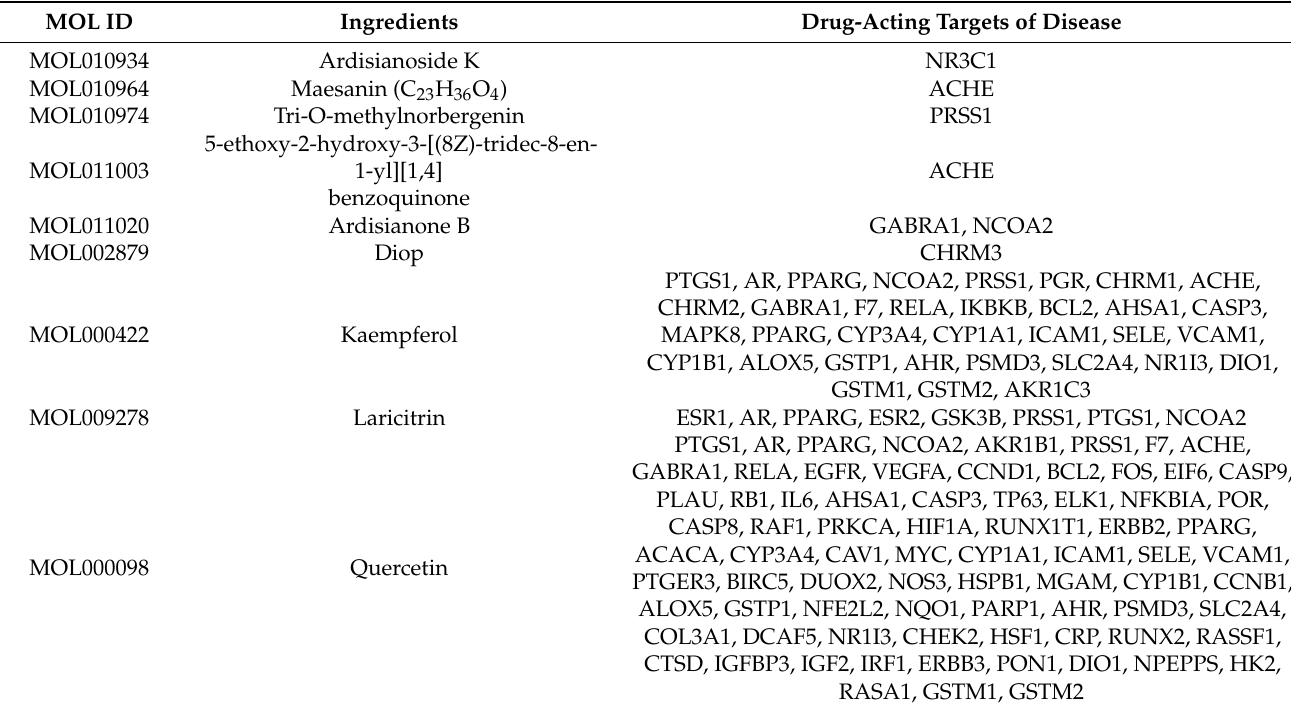
Figure 2. Intersection of drug targets and disease targets. Note: blue represents disease targets; red represents drug targets. Table 2. Possible targets for each